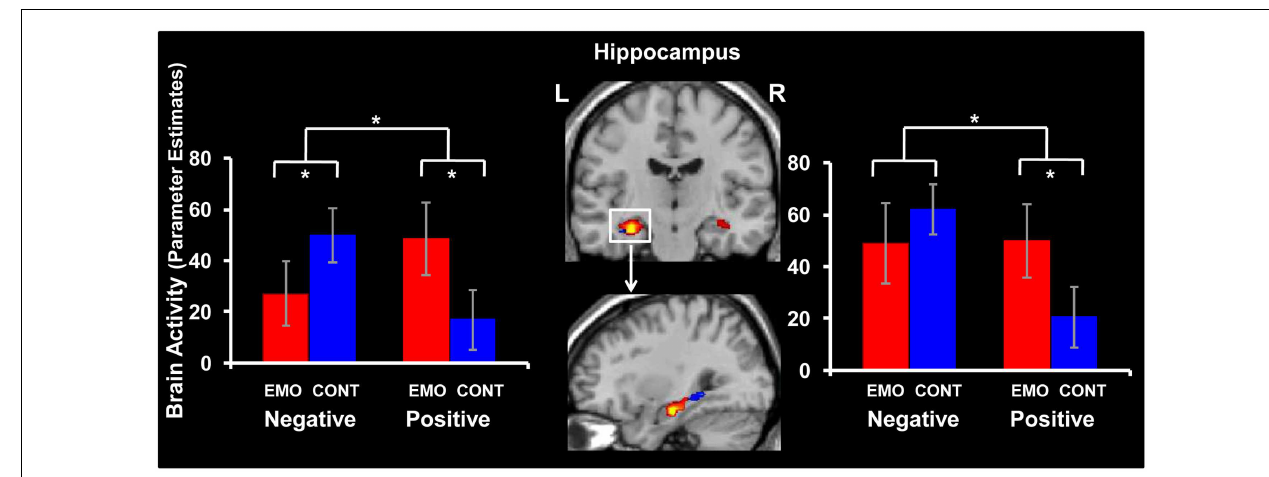
right HC is superimposed on a high resolution brain image displayed in a coronal view (top panel).The sagittal view (bottom panel) illustrates the posterior extension of activity in the left HC (blue blob), for negative memories (Context Negative > Emotion Negative).The bar graphs represent the contrasts estimates extracted from representative voxels of the interaction effects in left and right HC.The error bars correspond to the standard errors of the means. L = Left, R =